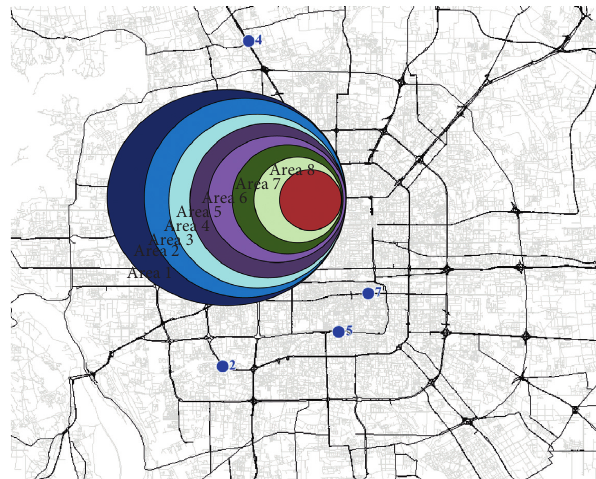
Figure 5: Eight selected areas used to evaluate prediction accuracy. Table 3: The FNN prediction system with different input variables.